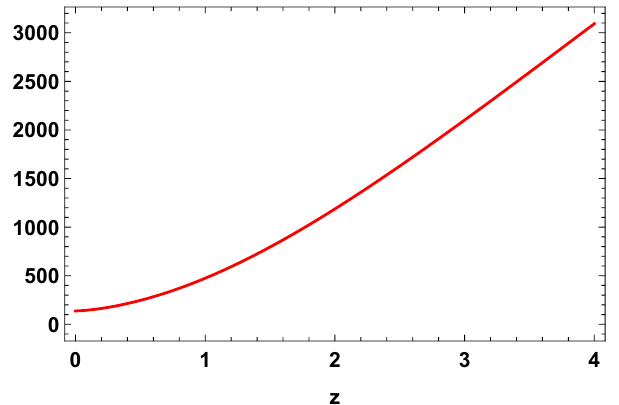
Figure 3. Evolution trajectory of the energy density, ρ (15), versus z with constraint values from the Hubble datasets [39] and α = − 0.01, n = 1.2.